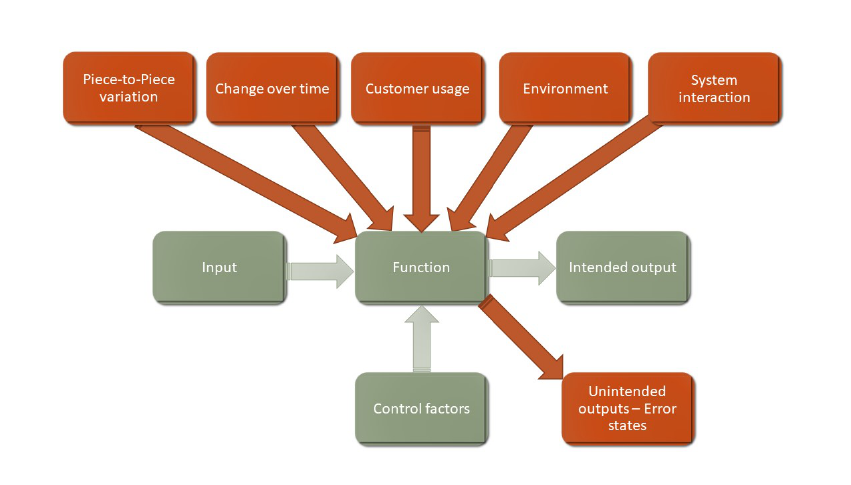
Figure 6. P-Diagram showing noises that may cause the failure modes of the function of a product.